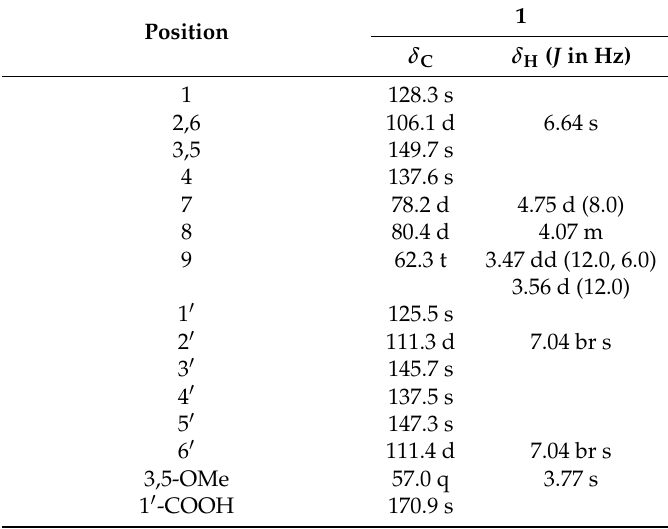
Table 1. 1 H (800 MHz) and 13 C (200 MHz) nuclear magnetic resonance (NMR) data of 1 in CD 3 OD a .